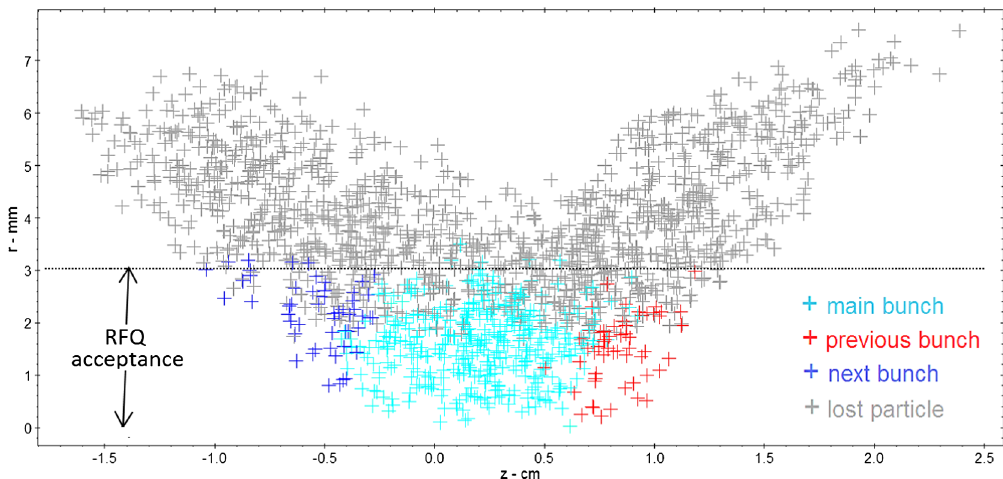
FIG. 5. Beam dynamics simulations: Snapshot of chopped beam at entrance to RFQ. colored particles are transmitted by RFQ — light blue particle eventually became main bunch, red and dark blue eventually became previous and next bunch — grey particles are not